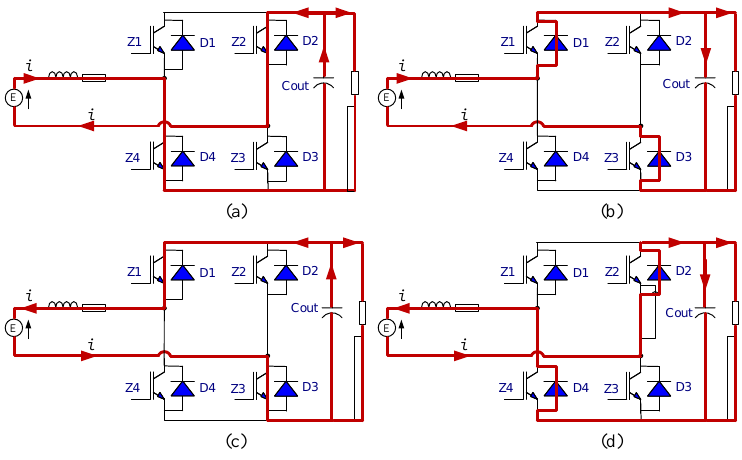
Figure 4. Current paths of AC/DC boost H-bridge (1 phase): ( a ) Z2 and Z4 switched on; ( b ) Z2 and